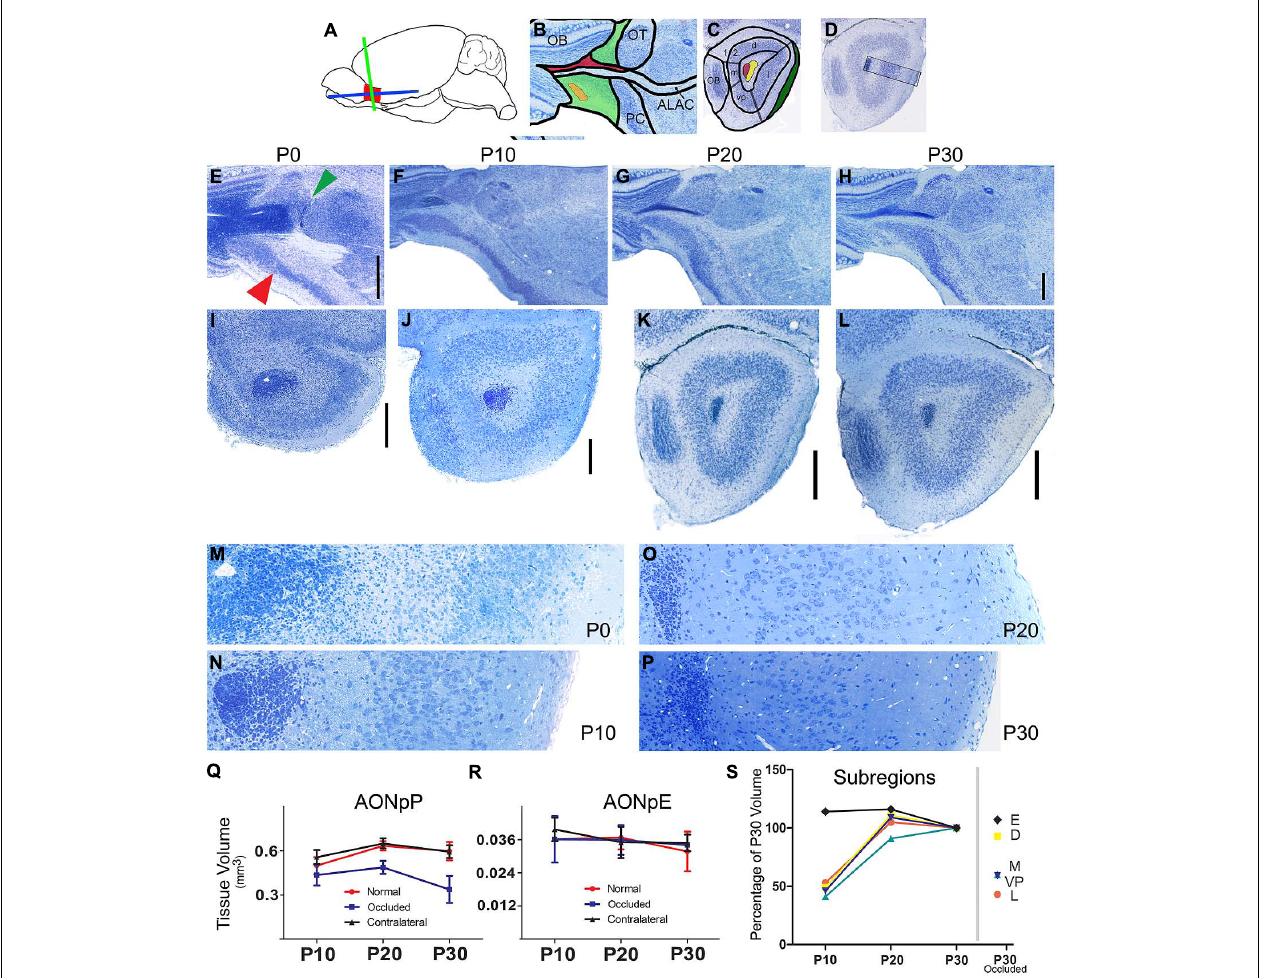
respectively. All subsequent coronal images maintain this orientation. At P0, the olfactory ventricle is still open in the core of the SVZ/RMS. With increasing age, the SVZ/RMS occupies a more compact region in the center of the peduncle and the encircling white matter becomes broader and more defined. The cellular zone of the AONpP, Layer 2, and the superficial plexiform layer (Layer 1) also become larger and more defined. Scale bars is 250 μ m. (M–P) . 2 μ m plastic sections taken from the SVZ/RMS (left) to the pial surface. With increasing age, the cell bodies in Layer 2 become less dense and the depth of Layer 1 increases. Each picture is 350 μ m tall. (Q , R) Age-related changes in the total volume of the AONpP (Q) and AONpE (R) . In control animals (red) AONpP exhibited considerable growth from P10 to P20, and remained relatively stable from P20 to P30. Unilateral naris occlusion (blue) resulted in a decrease in the size of the ipsilateral peduncle but had little effect on the contralateral side (black; “contralateral”). AONpE exhibited fewer age-related changes and less of an effect of naris occlusion. (S) Left side: data depicting the growth of AONpP pars lateralis [orange, dorsalis (yellow) medialis (blue] and ventroposterior (light blue) and AONpE (blue) using P30 volume as 100% of size. The constituent layers of AONpP exhibited rapid change from P10 to P20 (yellow – pars dorsalis,D; red – pars lateralis, L, turquoise – pars ventroposterior, V; dark blue: pars medialis, M), while few age-related changes were seen in AONpE (black). The data points on the right side of the graph show compare the sizes of the various regions in pups with unilateral naris occlusion from P1 to P30 to the data at left from normal controls at P30. Pars lateralis (L) , ventroposterior (VP) and medialis (M) exhibited the greatest reduction in size while both pars dorsalis (D) and AONpE (E) exhibited relatively little